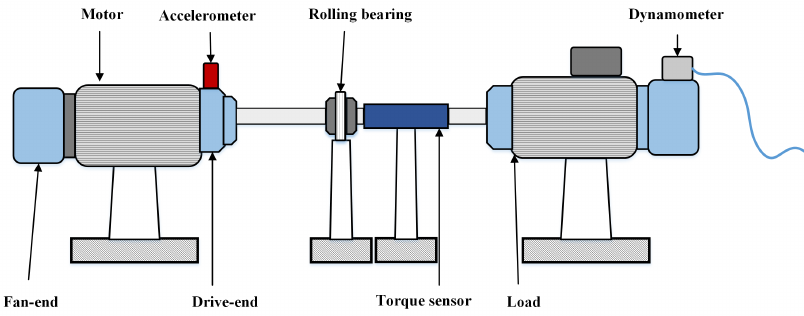
Figure 8. The platform for bearing fault diagnosis experiments of CWRU. Table 1. Distribution of rolling bearing